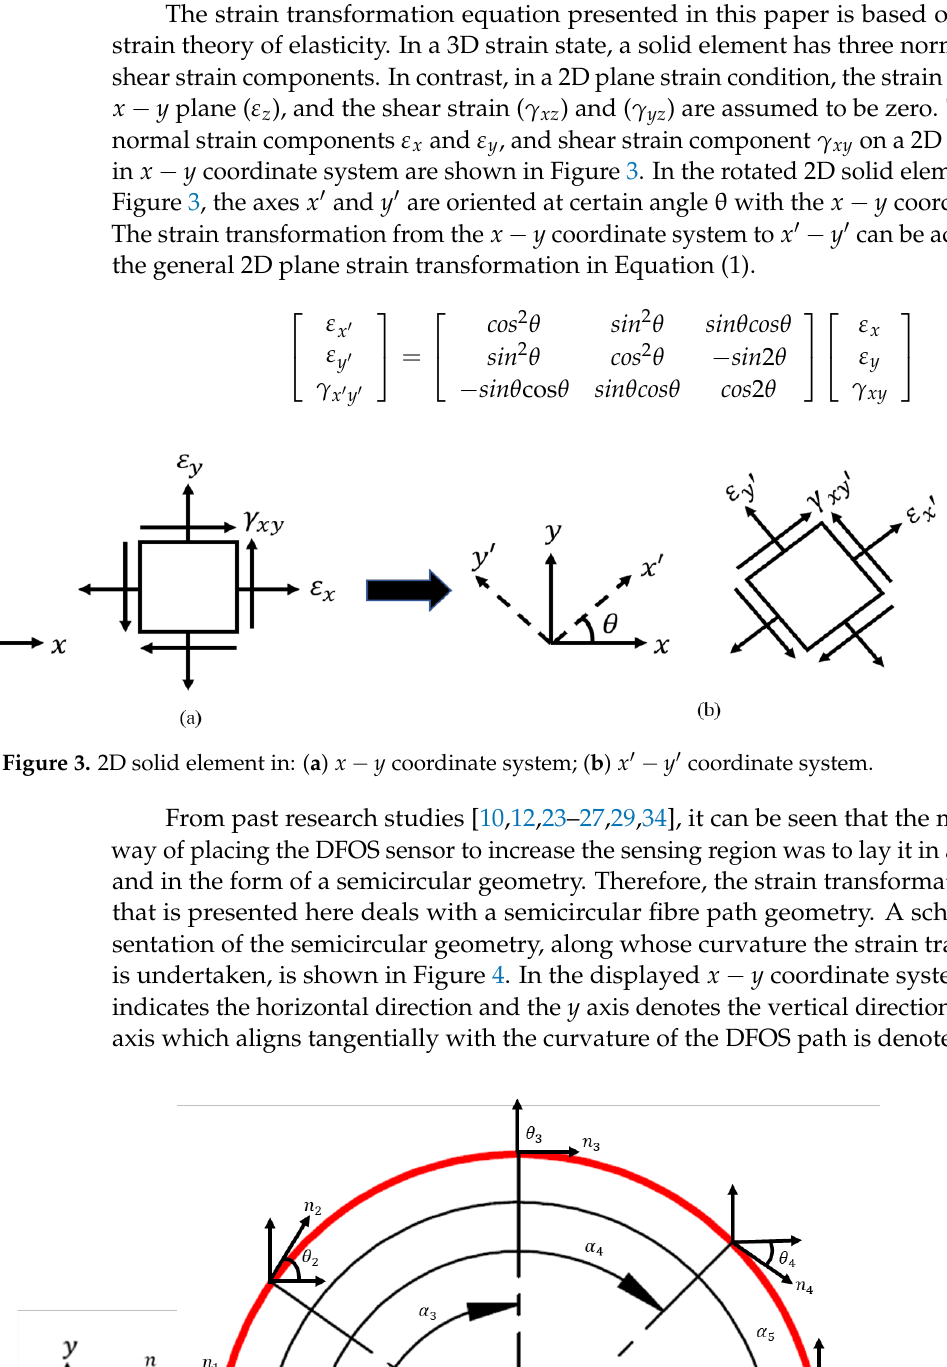
Figure 4. Schematic illustration of the semicircular geometry used in this study for strain transformation.